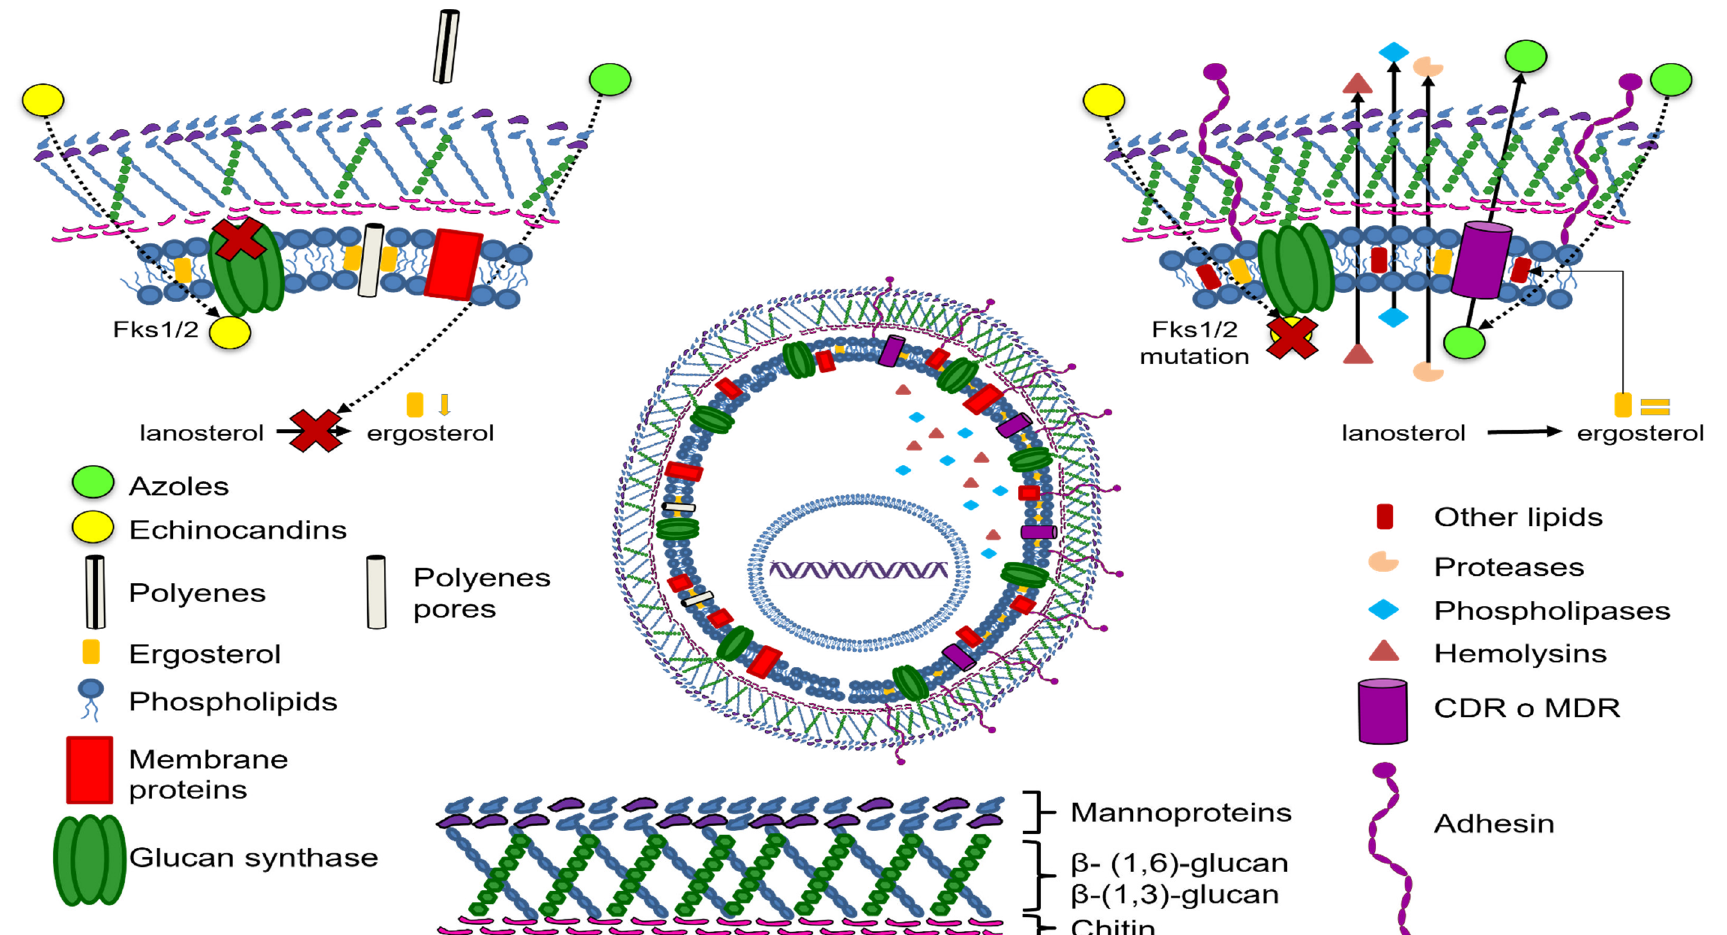
Figure 2. Candida glabrata drug resistance and virulence mechanisms.